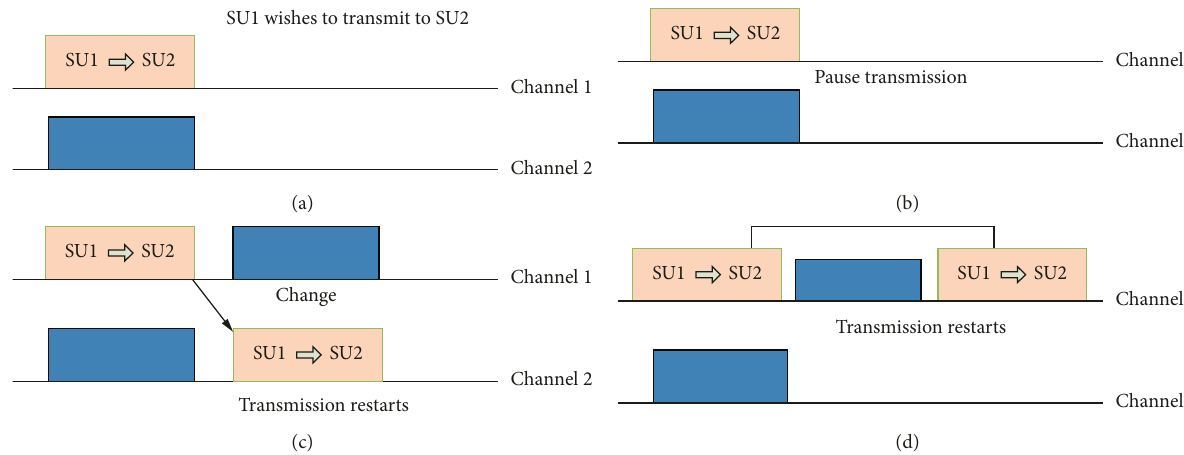
Figure 2: Illustration of spectrum mobility mechanism. (a) Transmission between secondary users (SUs). (b) The appearance of the primary user (PU). (c) Restart transmission on the selected channel. (d) Transmission restart on the same channel.